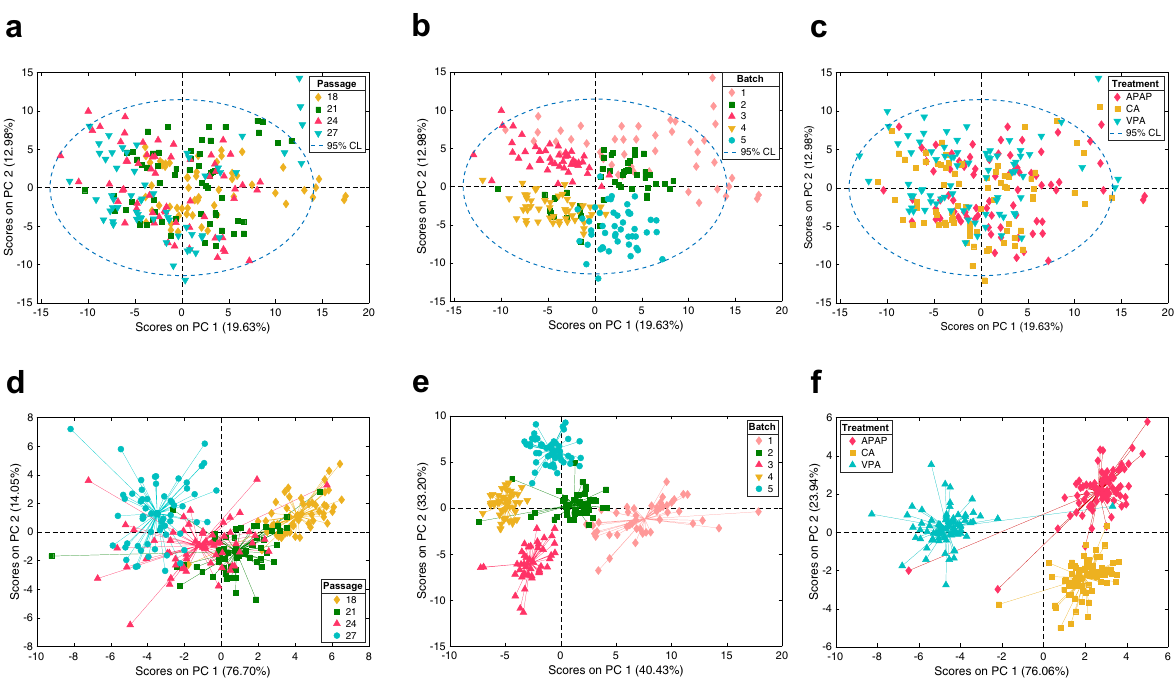
Figure 3. Multivariate data analysis of the influence of the cellular passage, processing batch and compound treatment by PCA and ASCA. Score plots from the analysis of 166 annotated metabolites based on cell passage ( a ), processing batch ( b ) and treatment ( c ). ASCA PC1 and PC2 scores plots for the factors ‘Passage’ (i.e. X Passage ) ( d ), ‘Batch’ (i.e. X Batch )’ ( e ), and ‘Treatment’ (i.e. X Treatment ) ( f function of the injection order evidenced that the within-batch effect was a relevant source of systematic error. PCA also identified QC#17 (injection order: 157) in the ESI + batch as a potential outlier (Fig. 2a,b(i)). The use of QC-SVRC algorithm 41 enabled the elimination of within-batch effect correction as shown in Fig. 2a,b(ii). The dispersion ratio (D-ratio*) 19 was used to identify features with low precision, and to exclude them from further analysis. Figure 2a,b(iii) show the cumulative distribution functions of the D-ratio* values in QCs before and after QC-SVR correction. Before and after QC-SVRC, the proportion of features with a D-ratio < 20% were 49.9% and 70.7% (ESI+/−) versus 93.5% and 96.9% (ESI+/−) respectively, demonstrating that the QC-normali- zation increases considerably the number of features with a D-ratio < 20%. In addition, Fig. 2a,b(iv) displays the percentage of retained features using an acceptance criterion for the D-ratio set to < 20%. Results show that the improvement in the data quality and the number of retained features does not depend on the size of the analyti- cal batch, providing a consistent increase in the relevant information which could be retrieved from the analysis, even for small batches (< 100 injections). Besides batch effect elimination, data analysis workflow included the elimination of uninformative features to improve the precision and accuracy of the metabolic models and reduce the likelihood of serendipity correlations. Impact of the cell passage number, processing batch and bioactive compound treatment on cell’s metabolomic data. PCA was used for an initial evaluation of the impact of the cell passage and the processing batch on the retrieved cell’s metabolome data. Figure 3 depicts the PC1 vs PC2 scores of a PCA model accounting for 32.6% of the initial data variation. Results showed a high overlap among samples from different passage groups, indicating that cellular passage was not one of the main sources of variation in the retrieved data (Fig. 3a). On the other hand, the clustering of samples according to their processing batch indicated that differ- ences associated to the processing day and the total time of storage until analysis were among the main sources of data variation (Fig. 3b). The random distribution of the processing batch clusters in the PCA scores space (Fig. 3a) and in the hierarchical clustering (see Fig. S2a) and the lack of linearity of the feature intensities with time (see Fig. S2b), suggested that this source of variability was mainly associated with the manual sample pro- cessing. ASCA was performed with the ANOVA model including 2-way interactions of three factors: X = Mean + X processing batch, and was responsible for 27.6% of the total variation. Score plots of the two first PCs of the ASCA factor ‘passage’ and ‘processing batch’, are depicted in Fig. 3d,e showing the calculated effect of cell passage and the processing batch. Score plots of PC1 showed that differ- ences between P18-21 with P24-27 were responsible for most of the cell passage associated variance (76.7%) (see Fig. 3d). Results depicted in Fig. 3e indicate that the distribution of sample batches was largely dominated by differences between Batches 1–2 and 3–4–5 along the first PC (40.4%). PCA also showed that the effects of the hepatotoxic compounds APAP and VPA were masked by the processing batch, and not included among the main